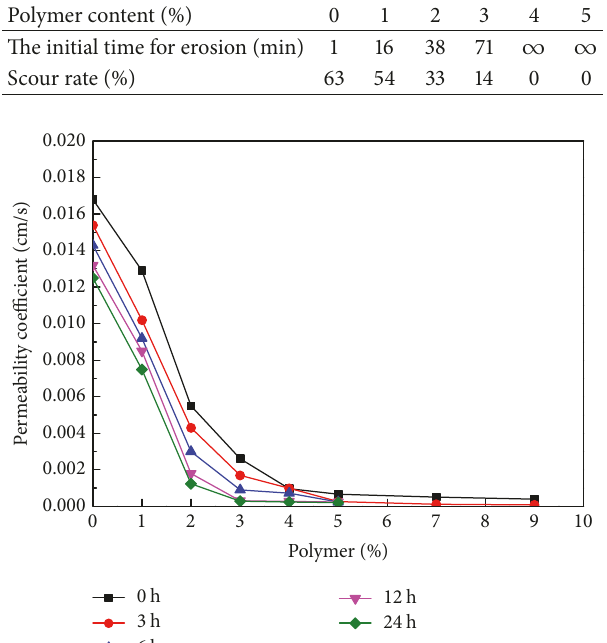
Table 3: The initial time and scour rate in runoff erosion test.